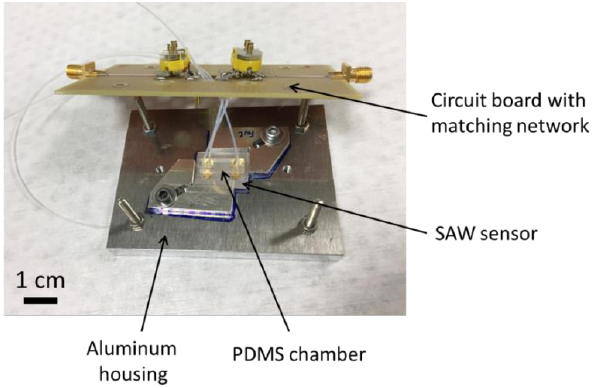
Figure 4. A SAW chip embedded in a custom-made aluminum fixture and covered with a poly(dimethylsiloxane) (PDMS) microfluidic chamber. The IDT was electrically connected to the matching network by spring contact probes.